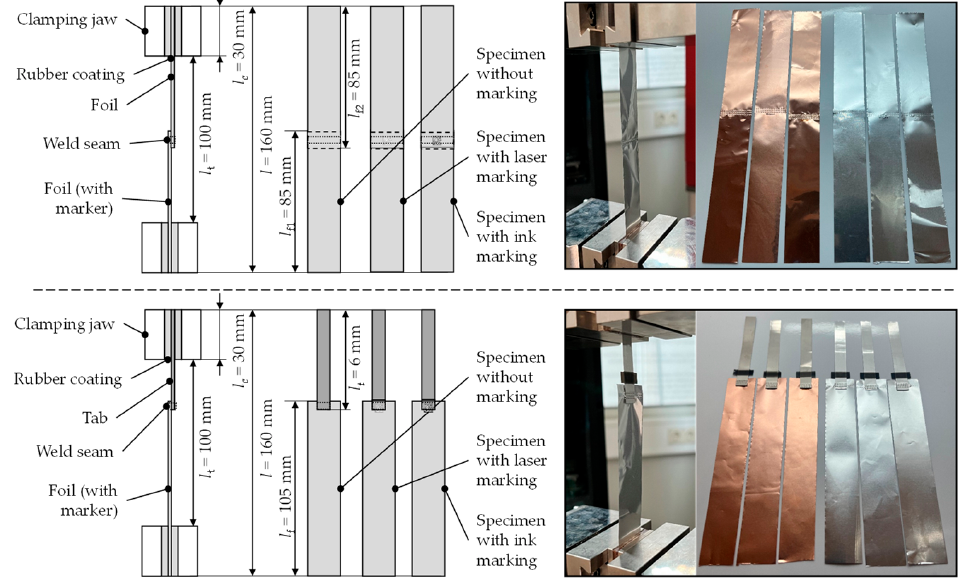
Figure 4. Top left: schematic drawing of the test setup for the foil–foil investigation. Top right: exemplary specimens with and without marking in the joining zone between the foils. Bottom left: schematic drawing of the test setup for the foil–tab investigation. Bottom right: exemplary specimens with and without marking in the joining zone between foil and tab.